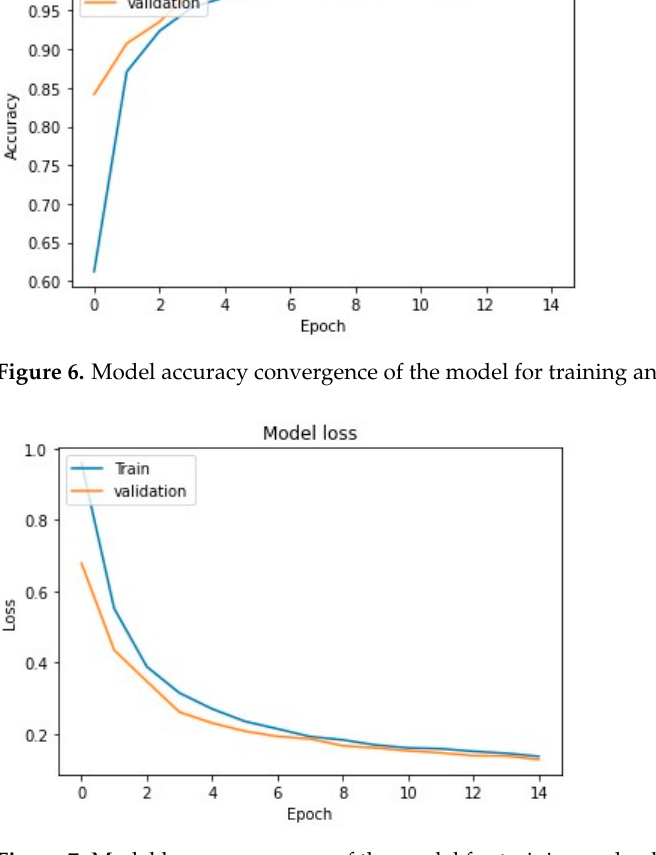
Figure 7. Model loss convergence of the model for training and validation.